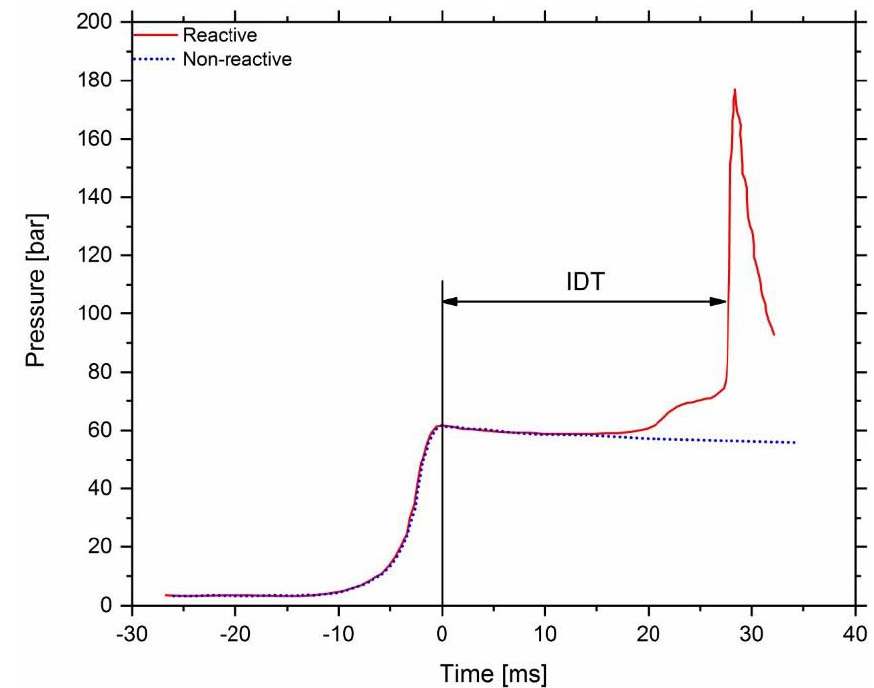
Figure 1. Pressure–time history of an experiment in the RCM. The definition of the ignition delay time (IDT), the reactive and the non-reactive pressure traces are shown.